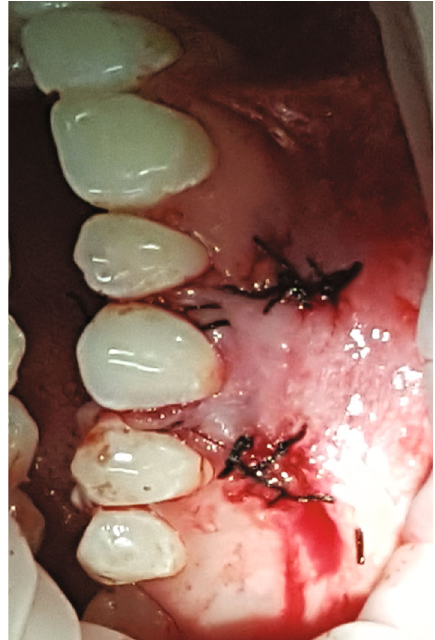
Figure 10: Flap coronally positioned and anchored with simple and suspension sutures.